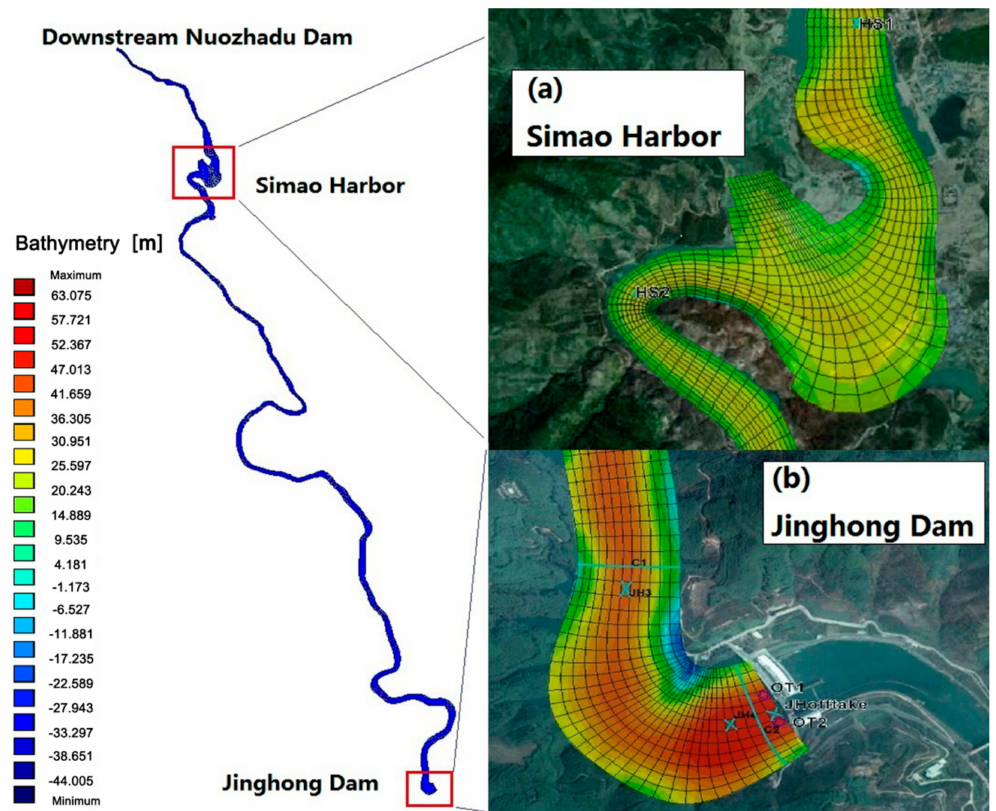
Figure 4. Horizontal discretization (about 11,000 horizontal grid points) and bathymetry of the Jinghong Reservoir with local enlargements at the site of ( a ) the Simao Harbor, and ( b ) the Jinghong Dam. We set 590 m above sea level as the datum (0 m) in the model so as to keep the water level a positive value through simulation period. Grid points with the riverbed higher than 590 m have a negative bathymetry